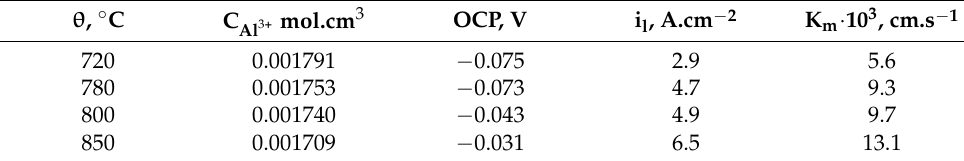
Table 1. Kinetic parameters of aluminium reduction in the single-capillary